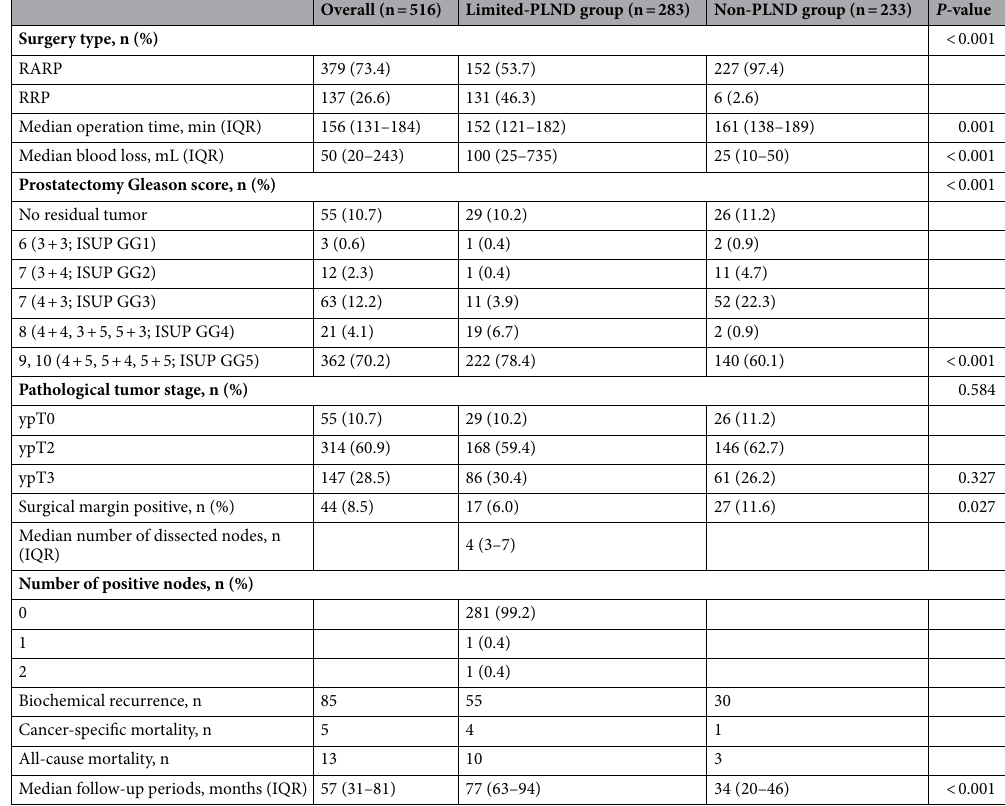
Table 2. Surgical and pathological outcomes. PLND pelvic lymph node dissection, RARP robot-assisted radical prostatectomy, RRP retropubic radical prostatectomy, IQR interquartile range, ISUP GG the International Society of Urological Pathology grade